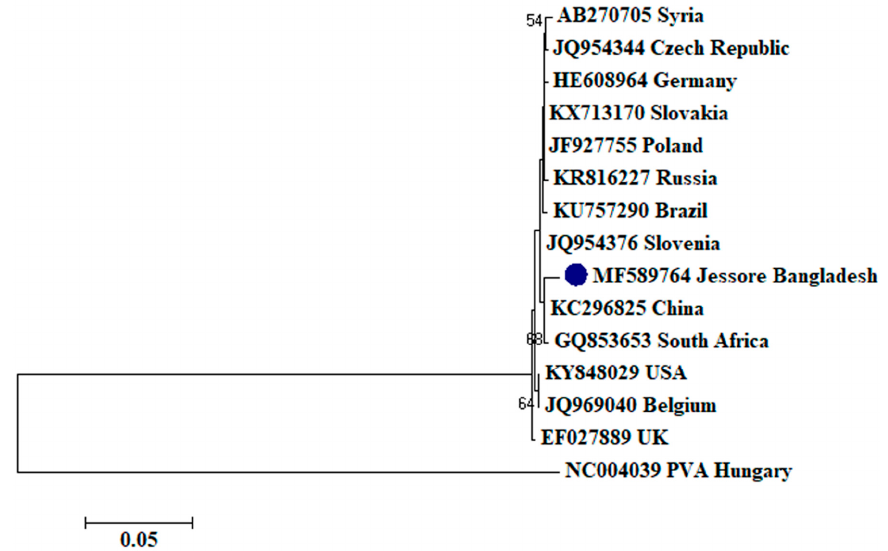
Figure 3. Phylogenetic analysis of Potato virus Y detected from Bangladesh based on the coat protein gene sequences (nt) of different selected isolates from the NCBI database. The phylogenetic tree was generated by MEGA7 using neighbor-joining method with 1000 bootstrap replicates, and only values > 50% are shown at the nodes. An isolate of Potato virus A (PVA) from Hungary was used as an outgroup.